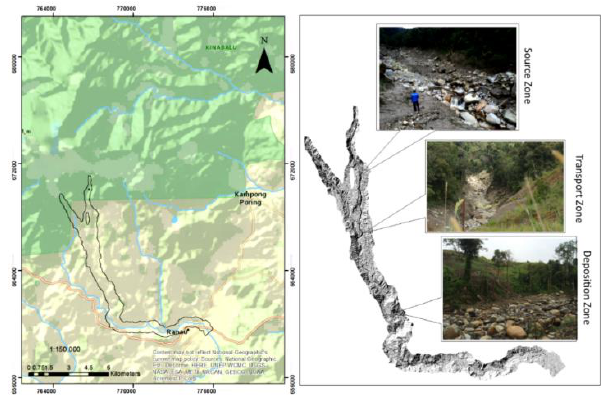
Figure 1. Location of study area at Mesilau River in Kundasang region which was struck by debris flow in June